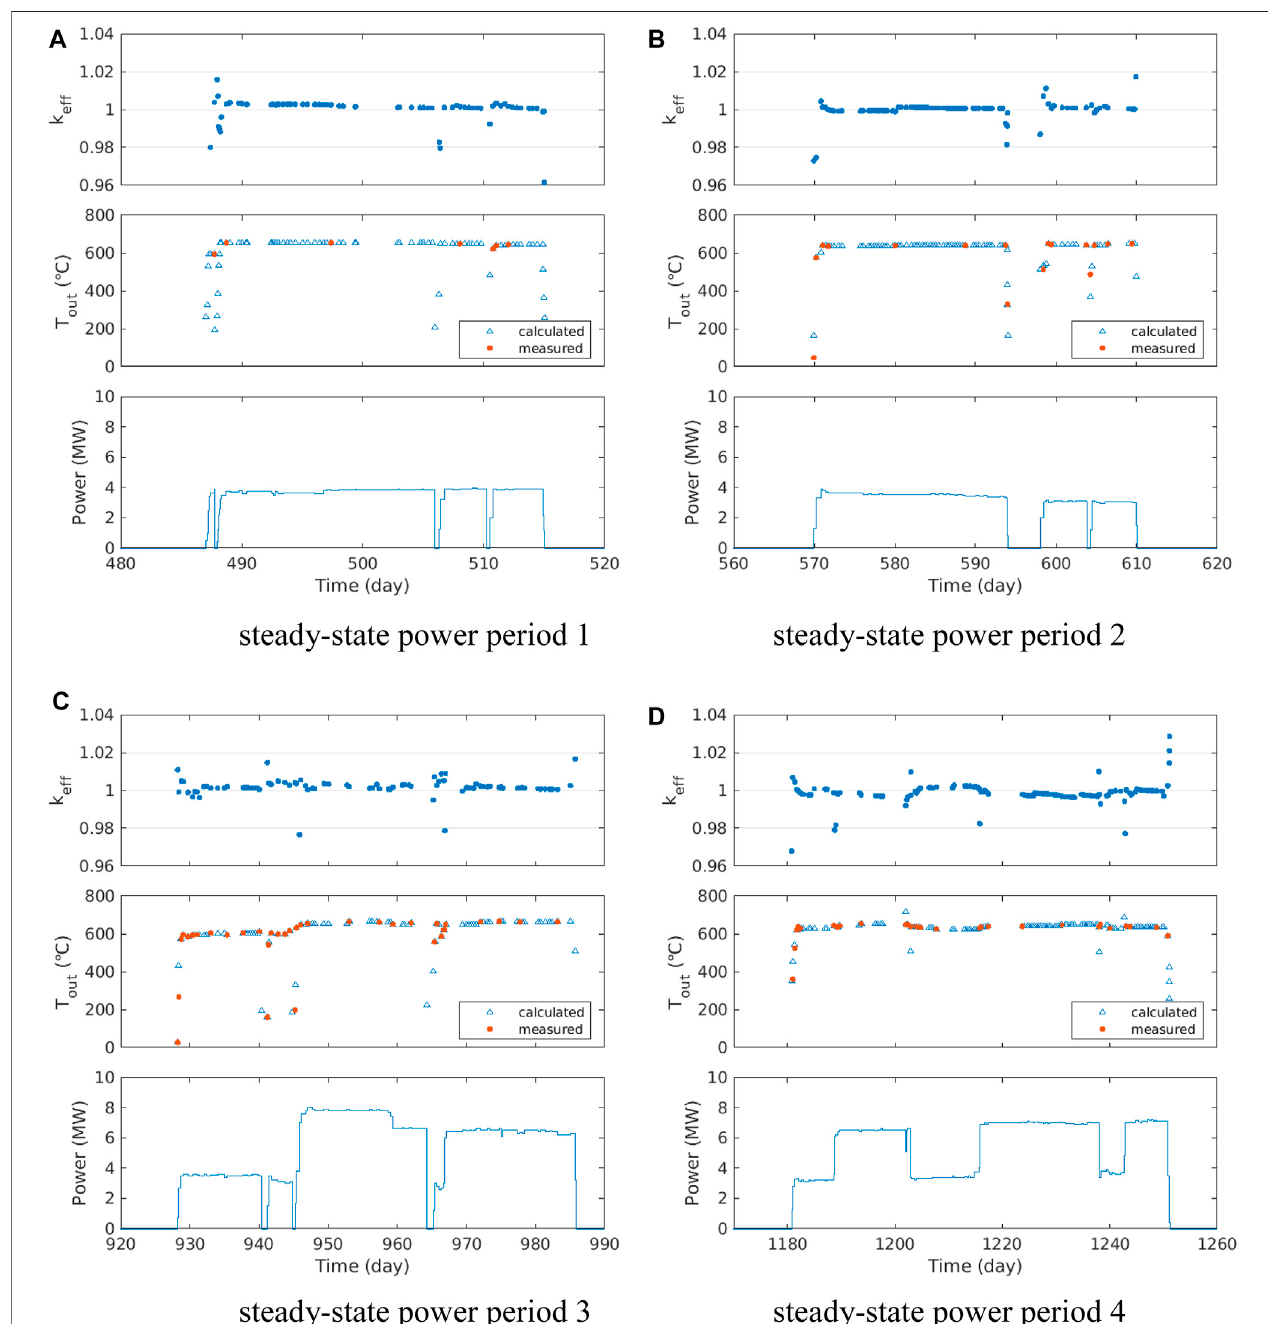
FIGURE 8 | (A) steady-state power period 1 (B) steady-state power period 2 (C) steady-state power period 3 (D) steady-state power period 4 (E) steady-state power period 5 (F) steady-state power period 6 (G) steady-state power period 7. Simulation results of the HTR-10 operation history.